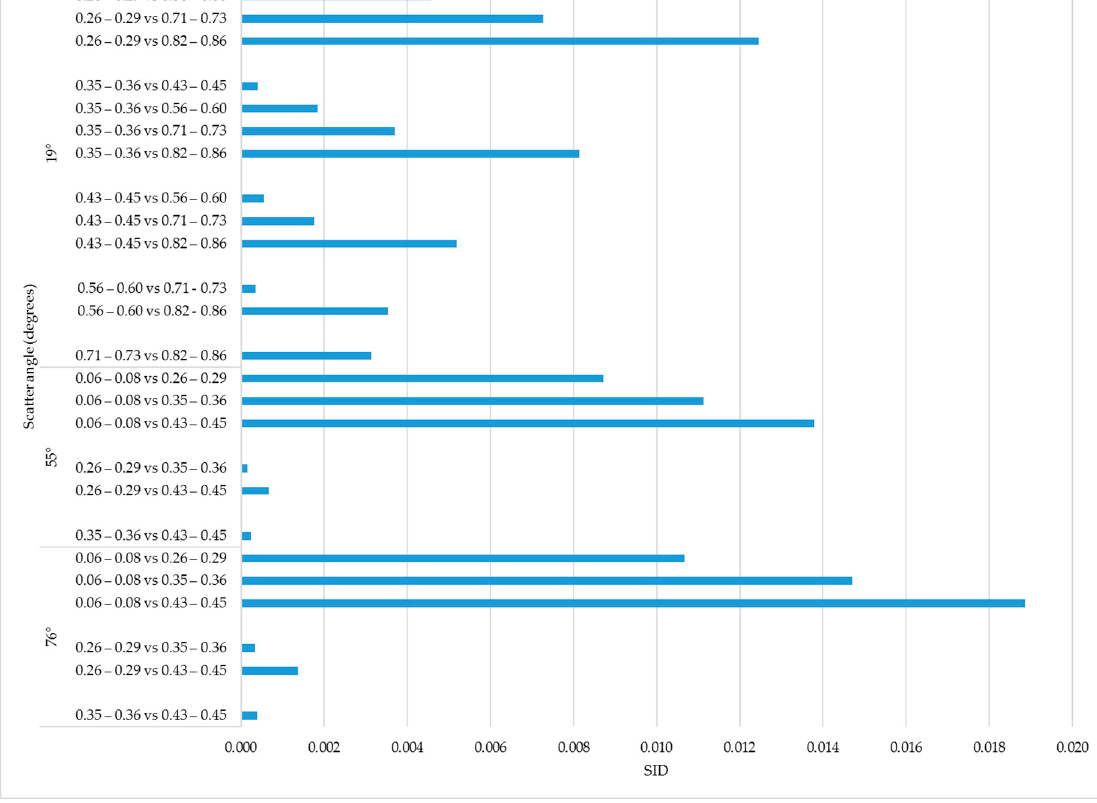
Figure 9. Spectral divergence values between sunlit fraction ranges for fixed scatter angles.